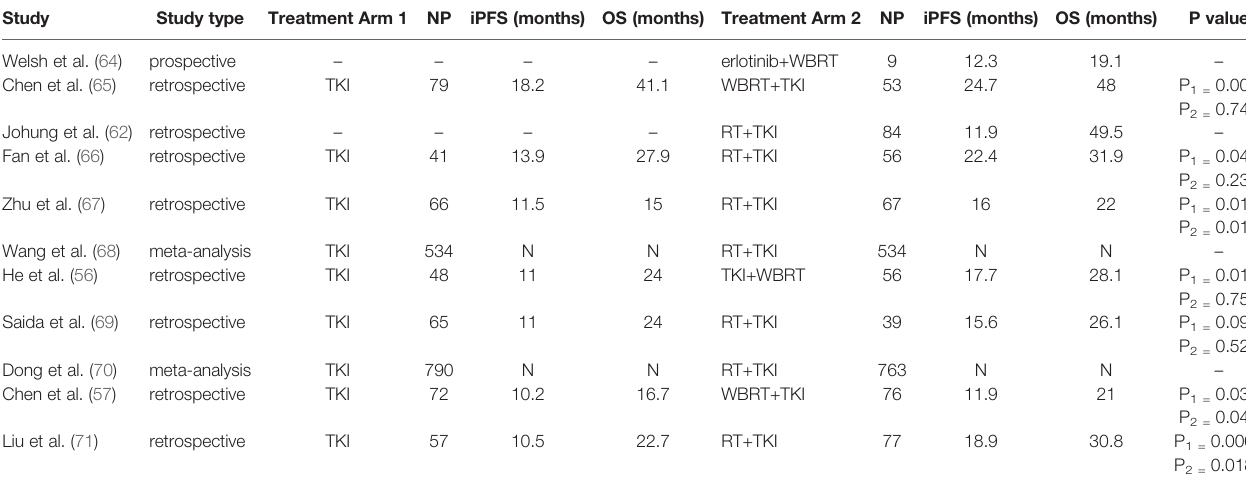
TABLE 2 | Clinical outcomes of TKI alone or combined with RT for BMs from NSCLC.